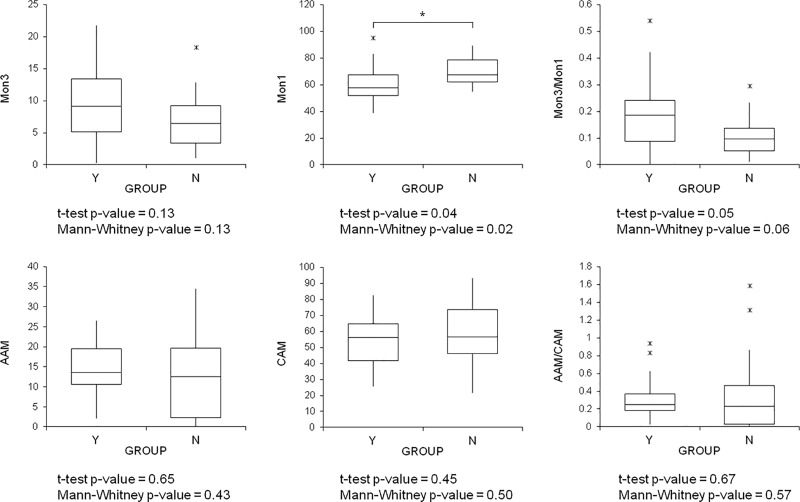
Box plots of predictors and related p-values for the t-test and Mann-Whitney test; Y indicates the group that developed BPD, N the group that did not. Asterisks (*) and horizontal bars indicate intergroup differences; p<0.05 was considered the limit for statistical significance.Box indicates medians with 25th and 75th percentiles, and whiskers indicate 5th and 95th percentiles; >95th or <5th percentiles are also shown (x).